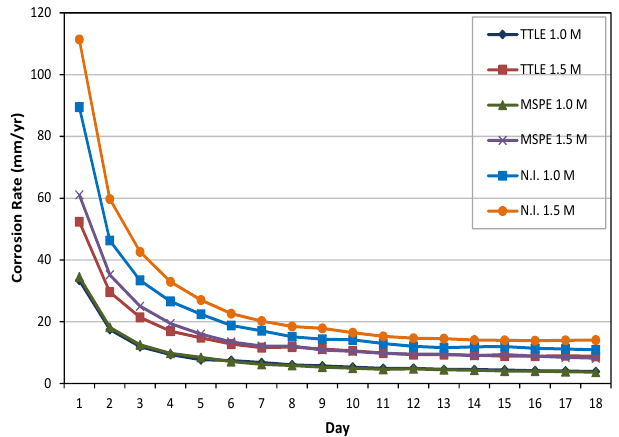
Fig. 4. Variation of corrosion rate with time at room temperature.